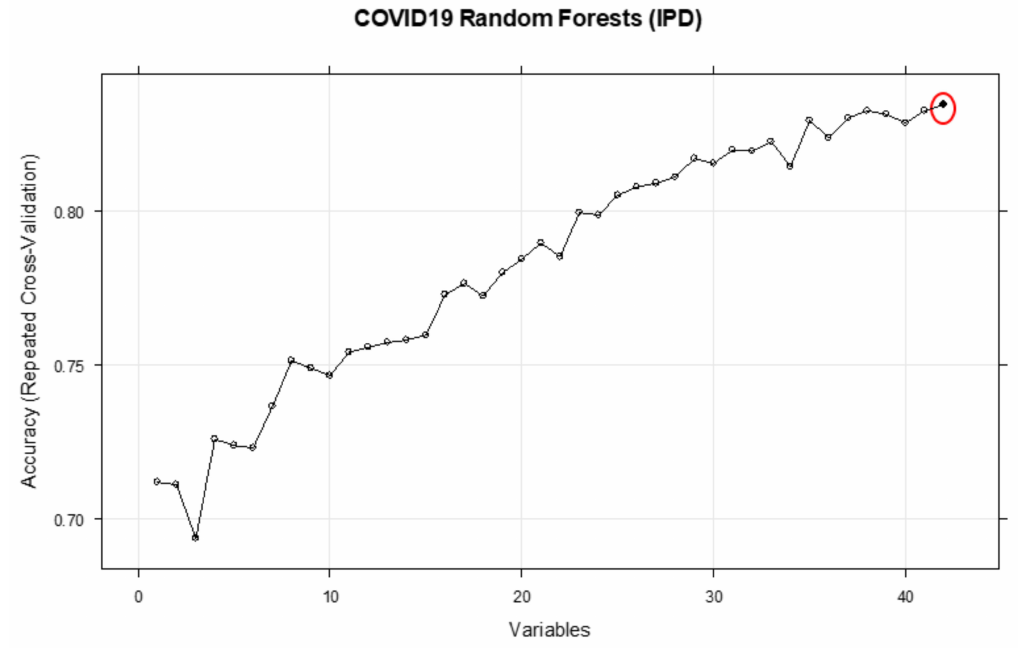
Figure 4. Performance of the RFE based on the ranks of the features of IPD. The red circle shows the maximum achievable performance based on the best combination of